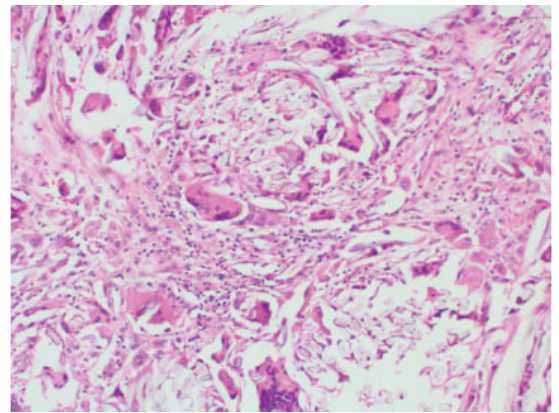
Fig. 3 Epithelioid histiocytic reaction with foreign body type multi- nuclear giant cells (hematoxylin-eosin (cid:1)